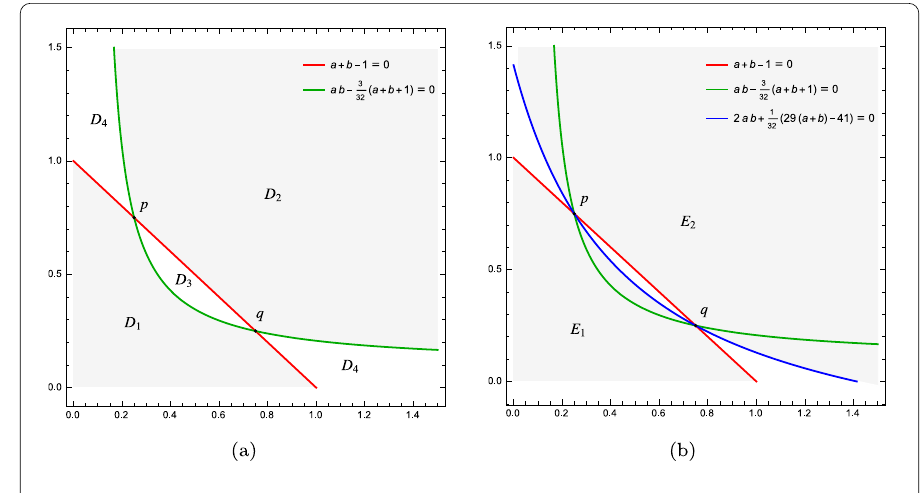
Figure 1 The regions D i for i = 1,2,3,4, E 1 , E 2 and their boundary